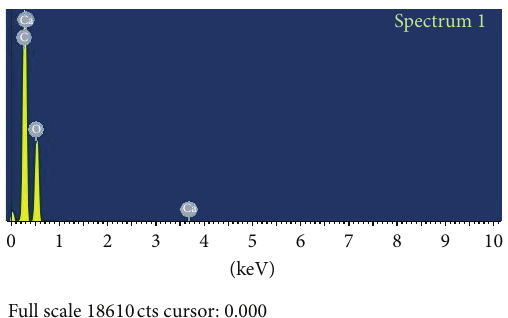
Full scale 18610 cts cursor: 0.000 Figure 4: EDS of CaHBSD before copper adsorption.